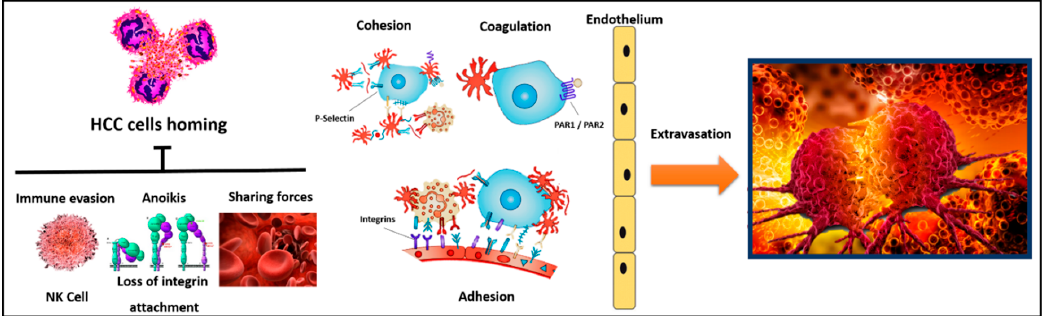
Figure 2. Molecular mechanisms connecting platelets and HCC, supporting tumor metastatic spread from the bloodstream.